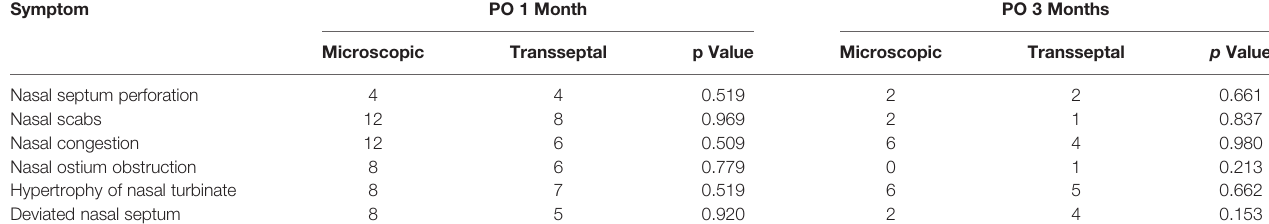
TABLE 8 | Nasal endoscopy outcomes.